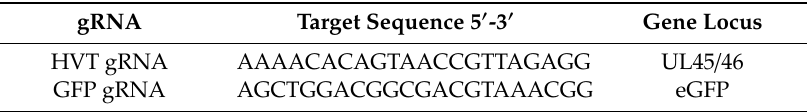
Table 1. Guide RNA. gRNA Target Sequence 5 (cid:48) -3 (cid:48) Gene Locus HVT gRNA AAAACACAGTAACCGTTAGAGG UL45 / 46 GFP gRNA AGCTGGACGGCGACGTAAACGG eGFP